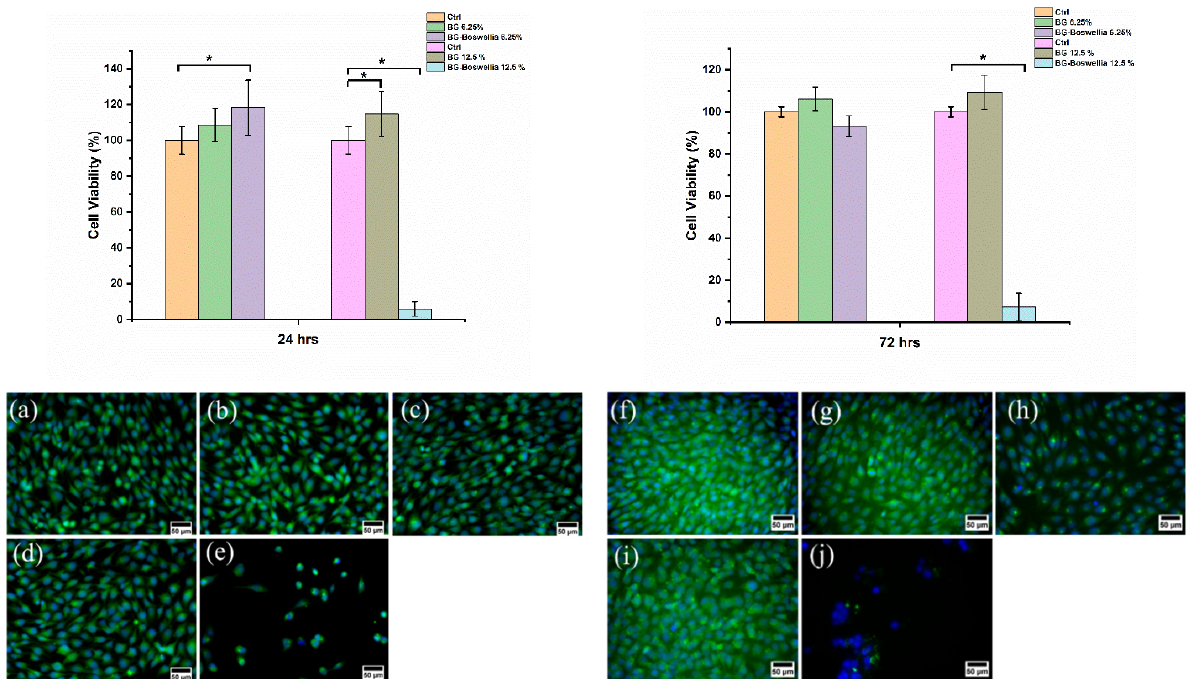
Figure 8. Graphs representing the time- and concentration-dependent effect of Boswellia sacra - loaded MBGNs on the MG-63 cell line and morphological responses of cells exposed to different concentrations after 24 h, presented in Ctrl ( a ), MBGNs 6.25% ( b ), MBGNs drug 6.25% ( c ), MBGNs 12.5% ( d ), MBGNs drug 12.5% ( e ), and after 72 h are presented in Ctrl ( f ), MBGNs 6.25% ( g ), MBGNs drug 6.25% ( h ), MBGNs 12.5% ( i ) and MBGNs drug 12.5% ( j ). Significant differences in cell viability values are marked by an asterisk (*).